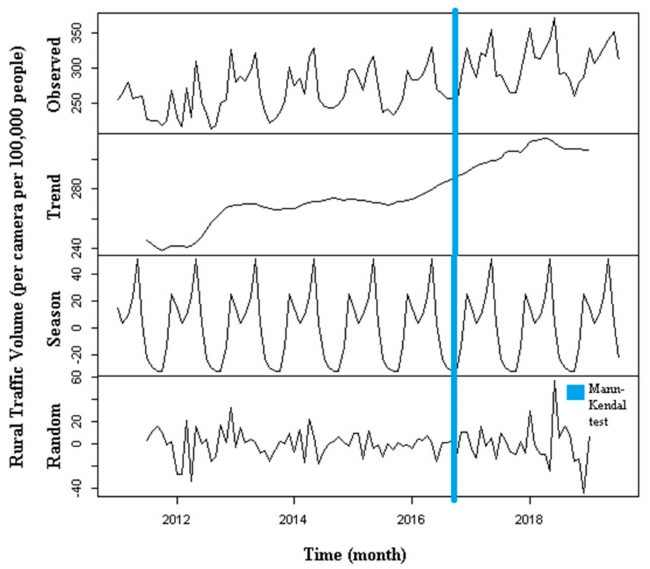
Figure 2. Decomposing the additive time series for monthly rural tra ffi c volume (per camera per 100,000 people) in Iran, with blue vertical lines showing the points analyzed with a Mann-Kendall Test, from March 2011 to October 2019.